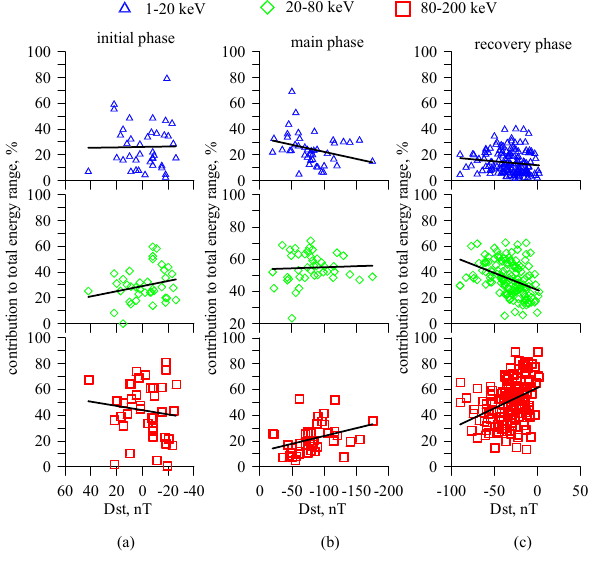
Fig. 3. 1–7 May 1998 storm event